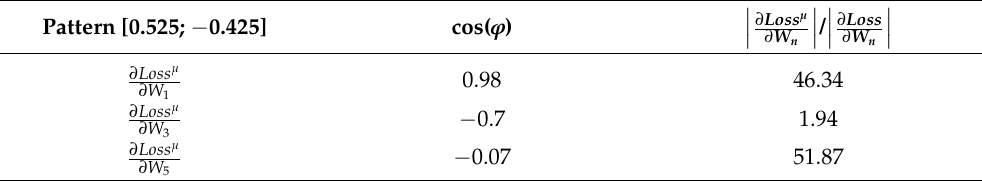
Table 4. Best learnt pattern’s ∂ Loss for the FC layers. As in the worst learnt pattern, the weight ∂ W n matrices are reshaped into a single row array value before doing the scalar multiplication.